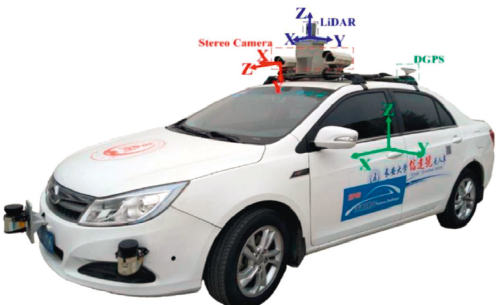
Figure 10: The autonomous vehicle used in the